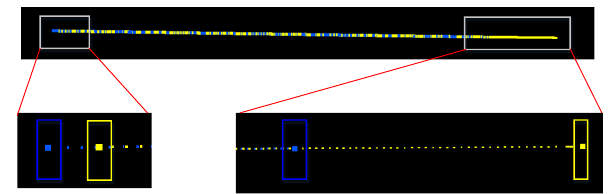
Figure 3 Details of identifying the topological relations between intersection